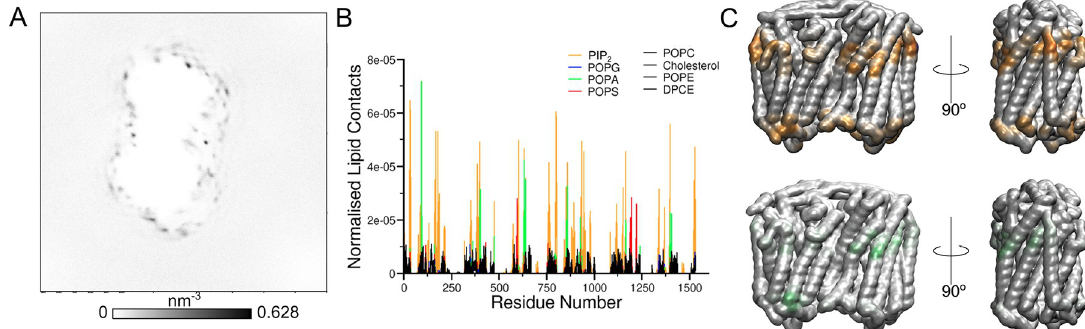
Fig 3. Vr -PPase in its native bilayer forms an anionic membrane fingerprint. The interactions between Vr- PPase and a realistic tonoplast membrane represented through A) the average density of the phosphate particles of the anionic lipids (PIP 2 , POPG, POPS and POPA) calculated using a combined trajectory fitted around the protein, B) the normalised number of contacts between the lipids in the bilayer and the residues of the protein, alongside C) a representation of the contacts on the 3D protein structure of PIP 2 (orange) and POPA